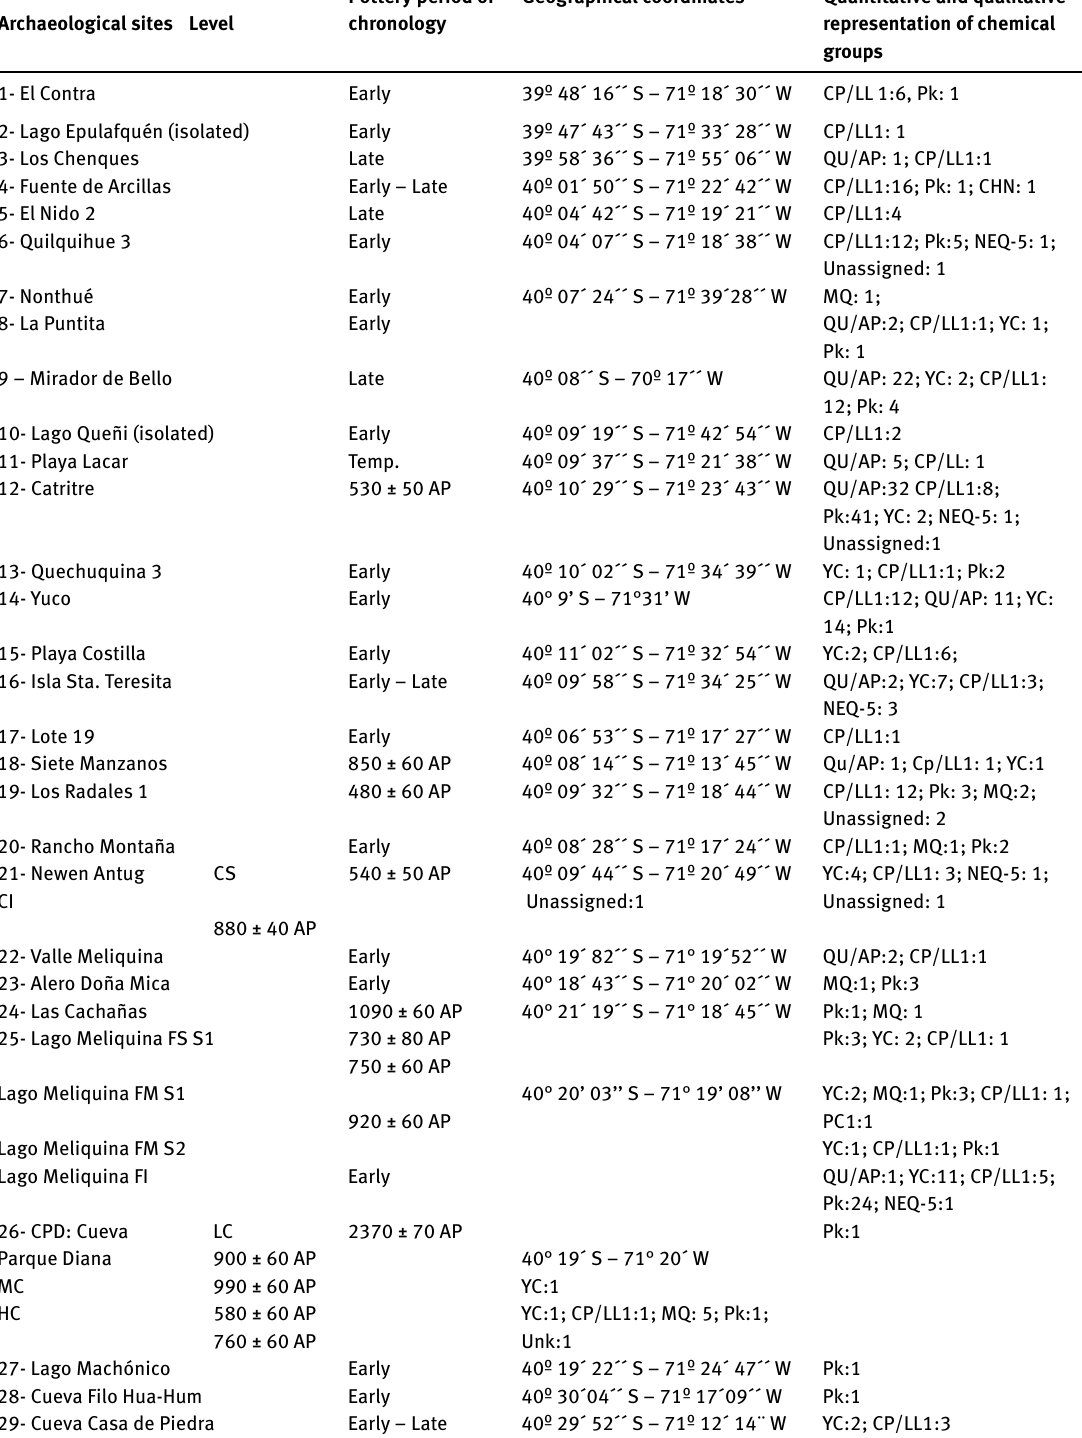
Table 1. Obsidian chemical groups analyzed. Early Pottery Period, II to XIth centuries AD. Late Pottery Period, XI–XVIth centu- ries AD: Late; LC: Lower Component; MC: Medium Component: HC: Higher Component. Unk: